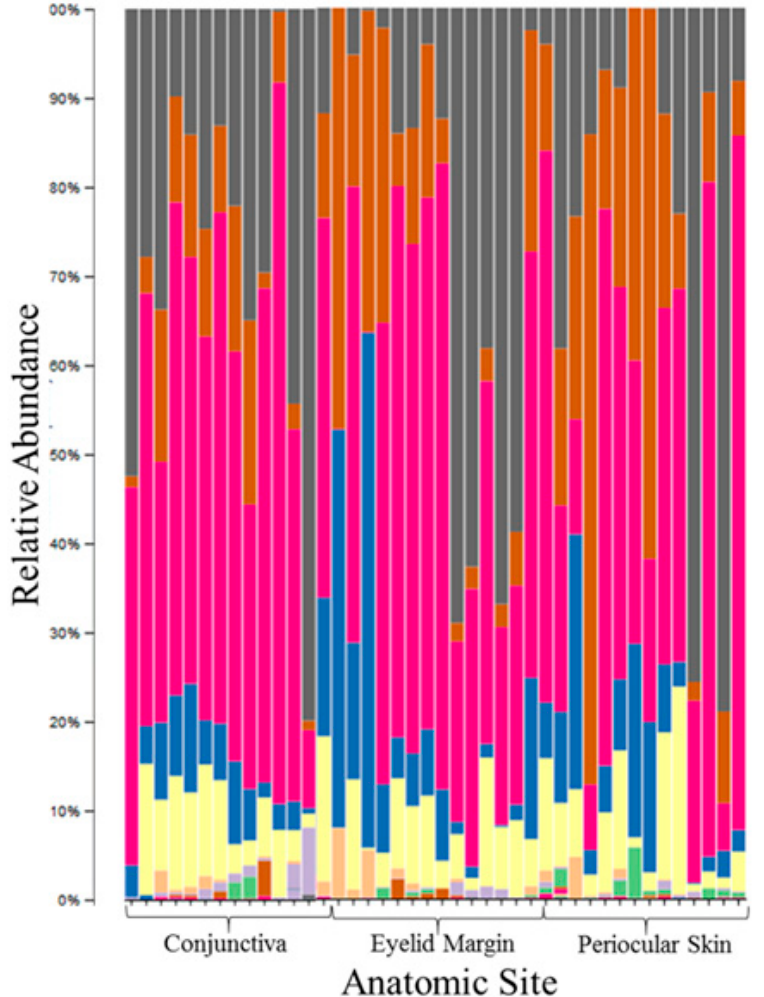
Figure 3. Taxa bar plot of the relative abundance at each anatomic site at the phylum level.